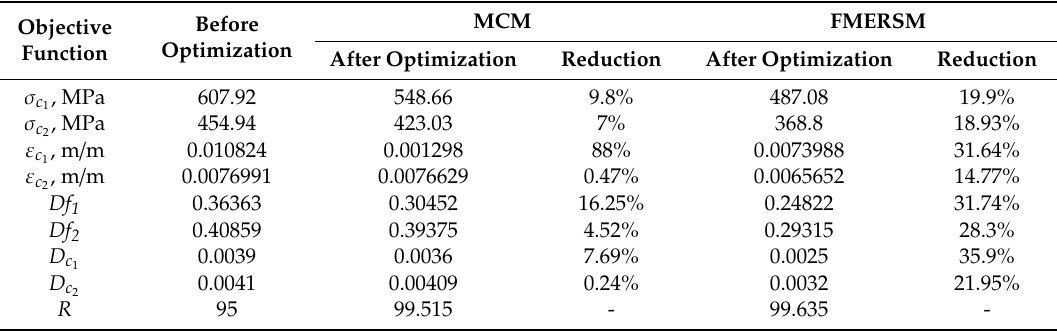
Table 7. Results of bladed disk optimization design with di ff erent